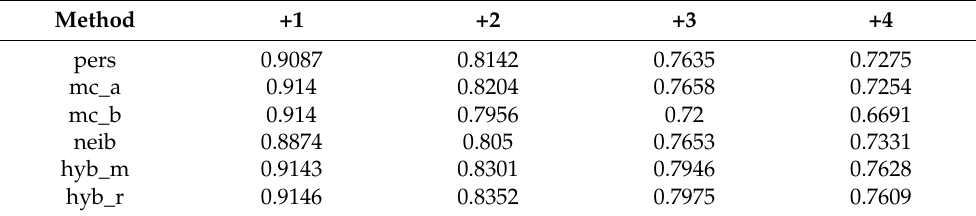
Table 4. Correlation coefficients of predicted and actual CMF time series for four lead time steps (+1 to +4) in 2020 for Berlin. The results for the other three cities can be found in Tables A1–A3 in Appendix